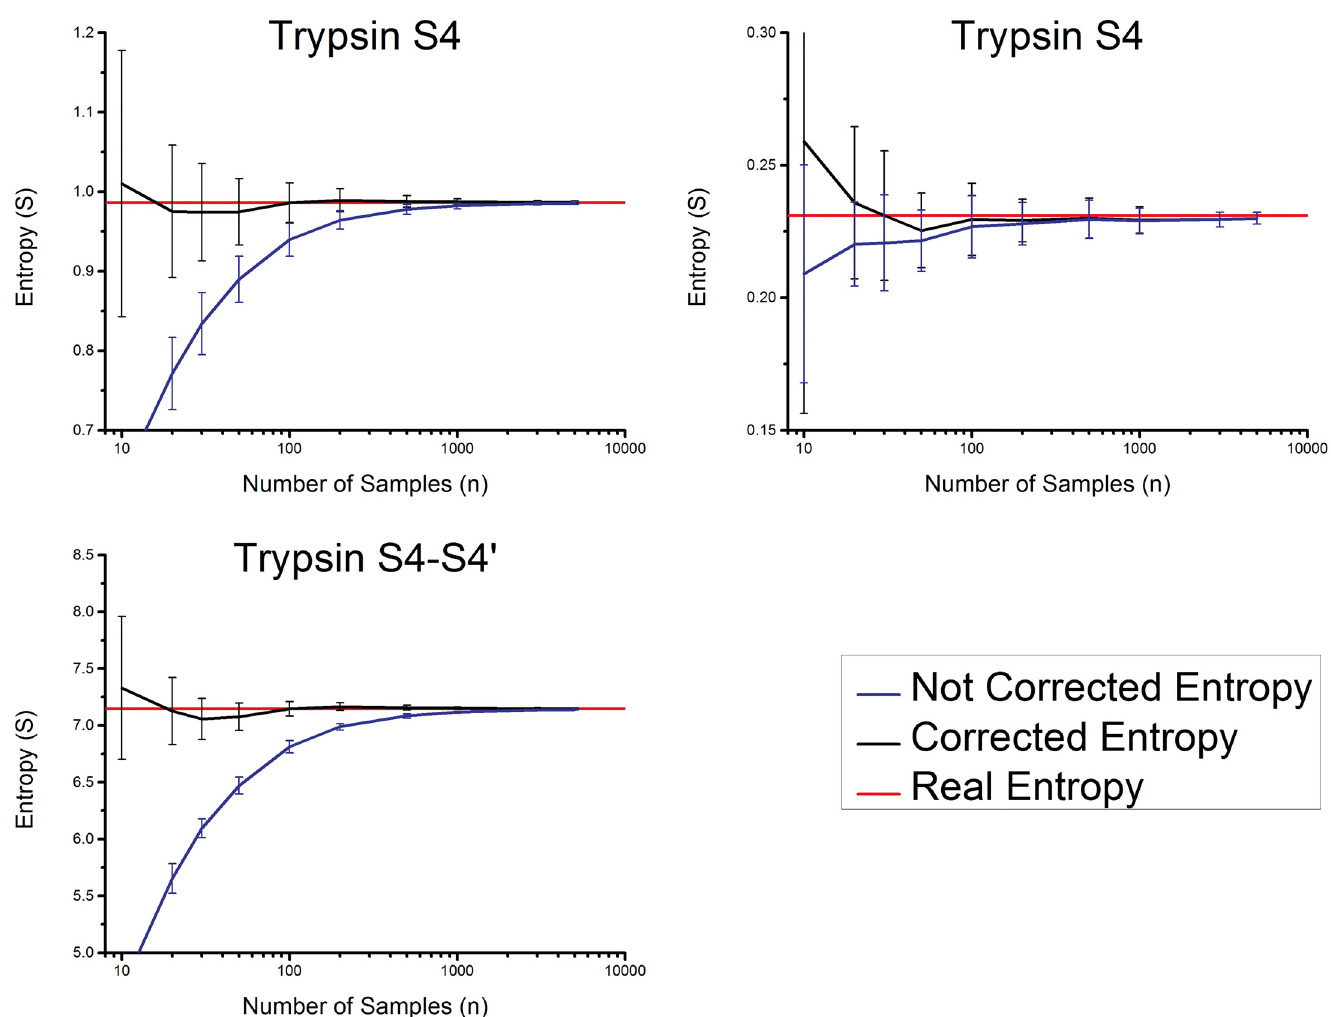
Fig 4. Trend of the na ï ve and estimated entropy for trypsin pocket S4, S1 and the sum of S4-S4 ’ pockets. The behavior of the corrected entropy (black line) with the number of known substrates. The red line is the real/infinite sample entropy and the blue line corresponds to the na ï ve estimated entropy value. Trend is plotted for S4 (upper left), S1 (upper right), and the sum of S4 to S4 ’ (lower